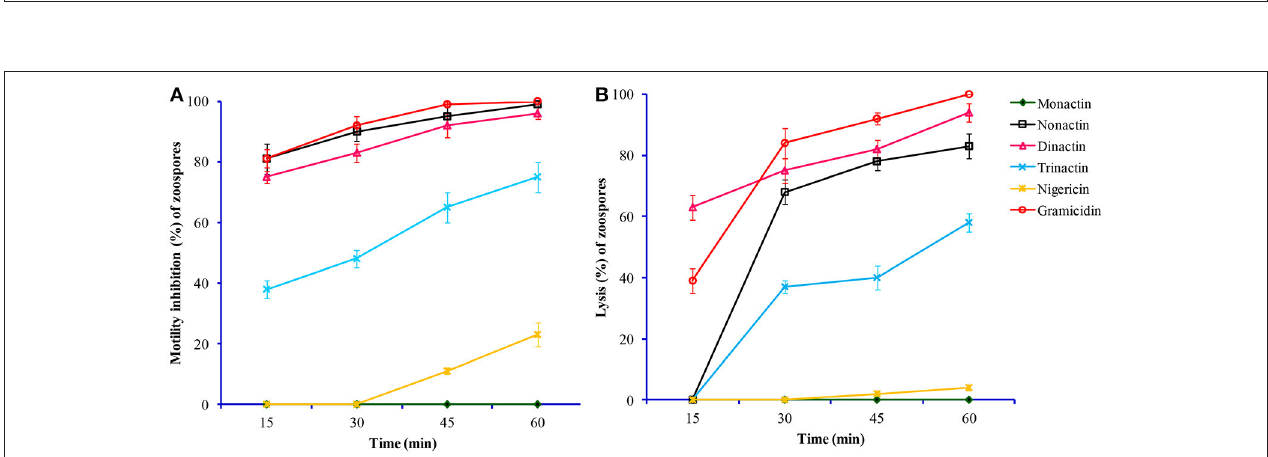
FIGURE 3 | Time-course comparative motility inhibitory (A) and lytic activities (B) of macrotetrolide antibiotics against zoospores of the grapevine downy mildew pathogen Plasmopara viticola at 0.5 µ g/ml ( p ≤ 0.05).